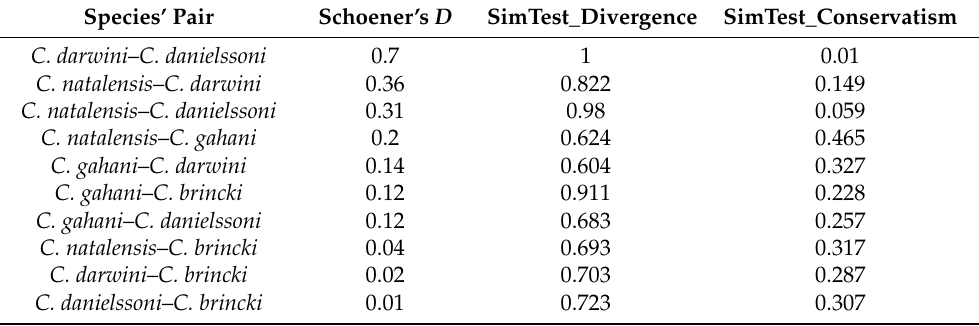
Figure 10. Kernel-based niche densities of the five target Chaetocnema species within the 2D environ- mental space encompassed by the top two principal components (in terms of percentage explained variance, values in brackets within axes labels) resulting from a PCA summarizing environmental het- erogeneity in the study region based on the 19 bioclimatic variables and on the percentage coverage from the 17 vegetation formations. Table 3. For each Chaetocnema species’ pair reported: overlap in niche density as measured through the Schoener’s D index; p -value of the niche similarity test conducted testing for niche divergence as alternative hypothesis; p -value of the niche similarity test conducted testing for niche conservatism as alternative